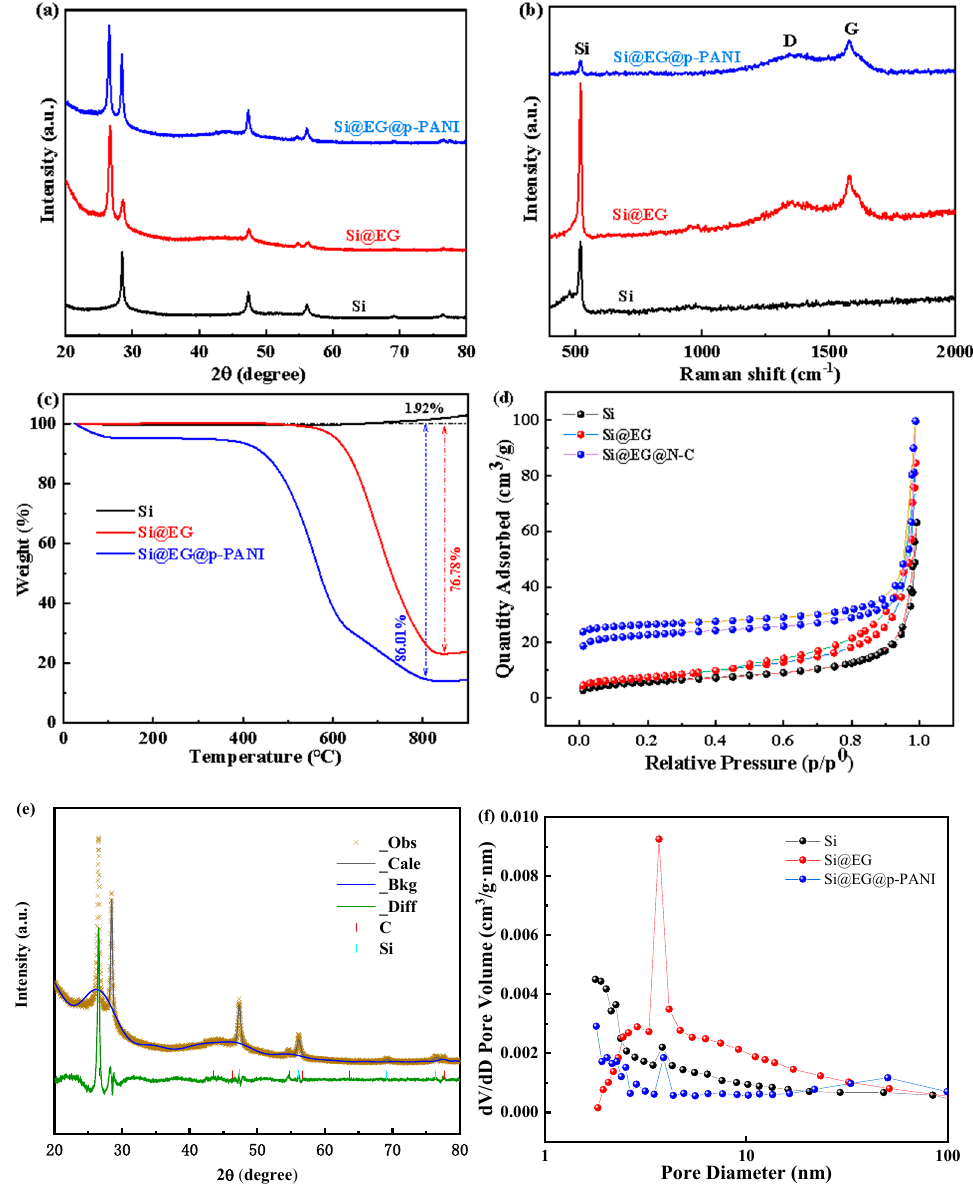
Figure 3. ( a ) XRD patterns, ( b ) Raman spectra, ( c ) TGA curves of raw Si powder, Si@EG composite